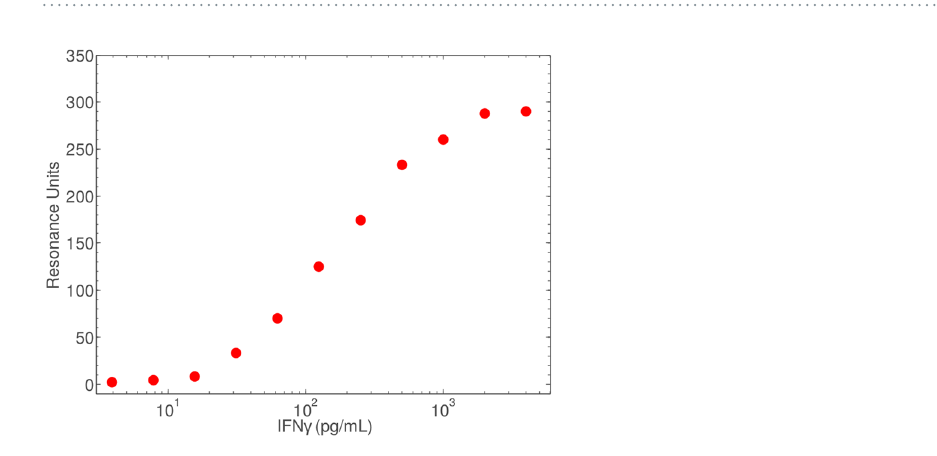
Figure 1. Biological components of the original colorimetric diagnostic assay system (R + D Biosystems) and the converted assay been used for the eELISA detection method.